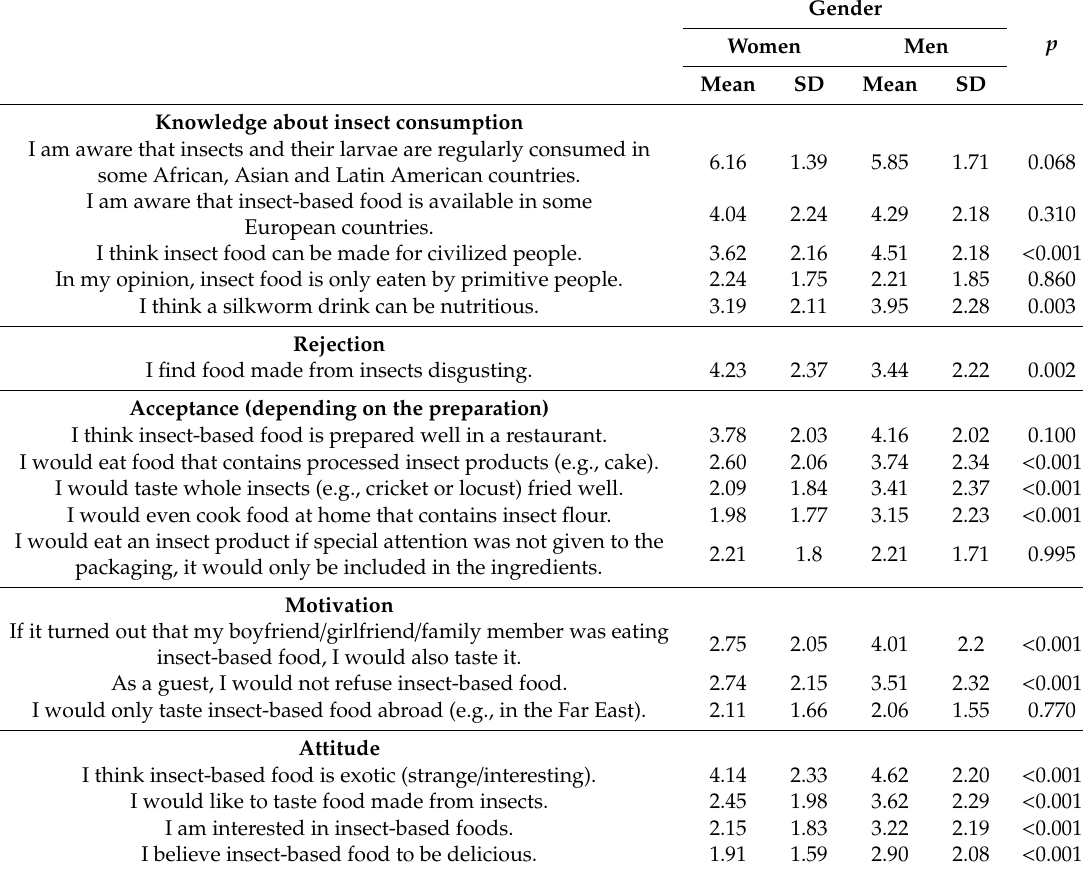
Table 2. E ff ect of gender of respondents on opinions on insect-based foods and their consumption.